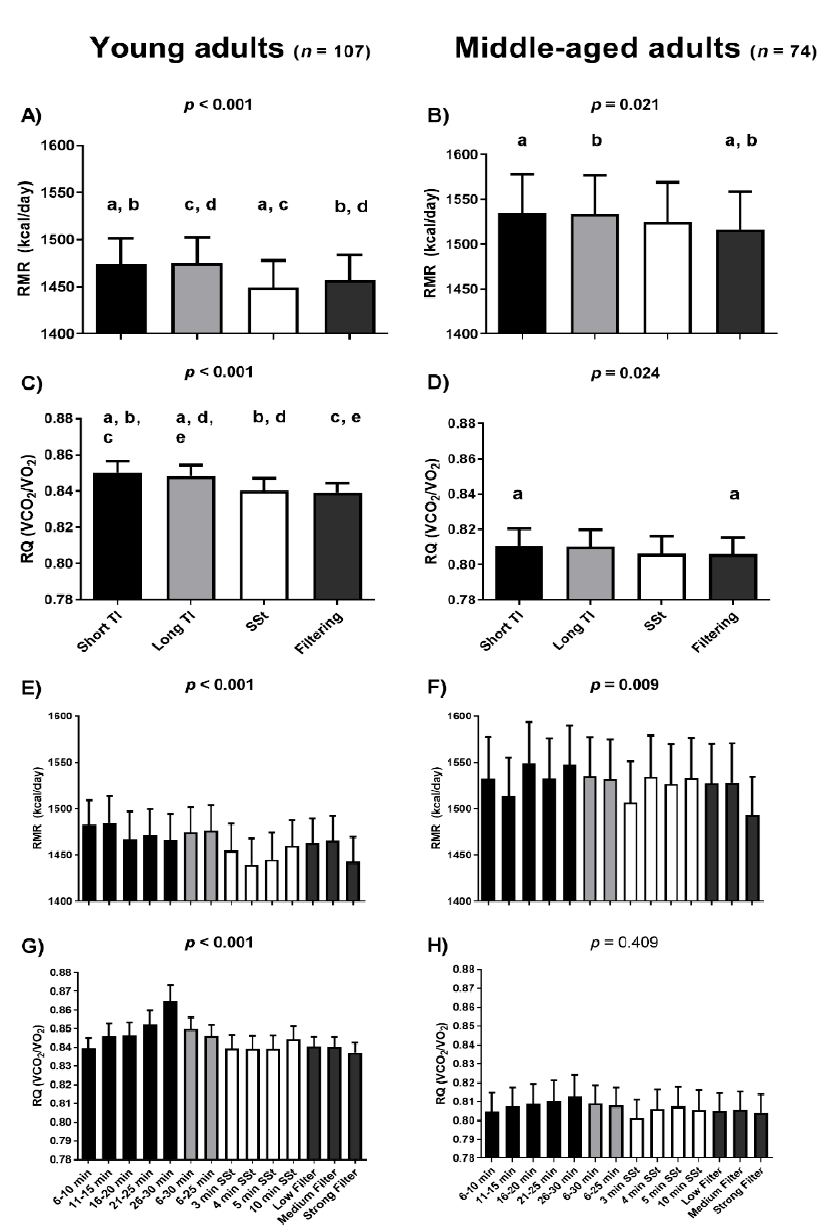
Figure 1. Di ff erences among gas exchange data selection methods with respect to resting metabolic rate (RMR) and respiratory quotient (RQ) estimates. Black columns represent short time interval (TI) periods (i.e., the means of the per minute ventilation data ( p MVD]) values for all variables available for these time periods, panels A – D ; the p MVD values for each short TI period, panels E , F ). Light grey columns represent long TI periods (i.e., the means of the p MVD values for all variables available for these time periods, panels A – D ; the means of the p MVD values for each long TI period, panels E,F ). White columns represent steady state (SSt) periods (i.e., the means of the p MVD values for all variables available for these SSt periods, panels A – D ; the means of the p MVD values for each SSt period, panels E , F ). Dark grey columns represent filtering methods (i.e., the means of the p MVD values for all variables available for these filtering periods, panels A – D ; the means of the p MVD values for each filtering period, panels E , F ). p -values come from repeated-measures analysis of variance (ANOVA). Identical indicatory letters highlight di ff erences as determined by post-hoc Bonferroni analysis. Data are presented as mean and standard error of the mean (SEM). Min: minutes; VCO 2 : production of carbon dioxide; VO 2 : consumption of oxygen.